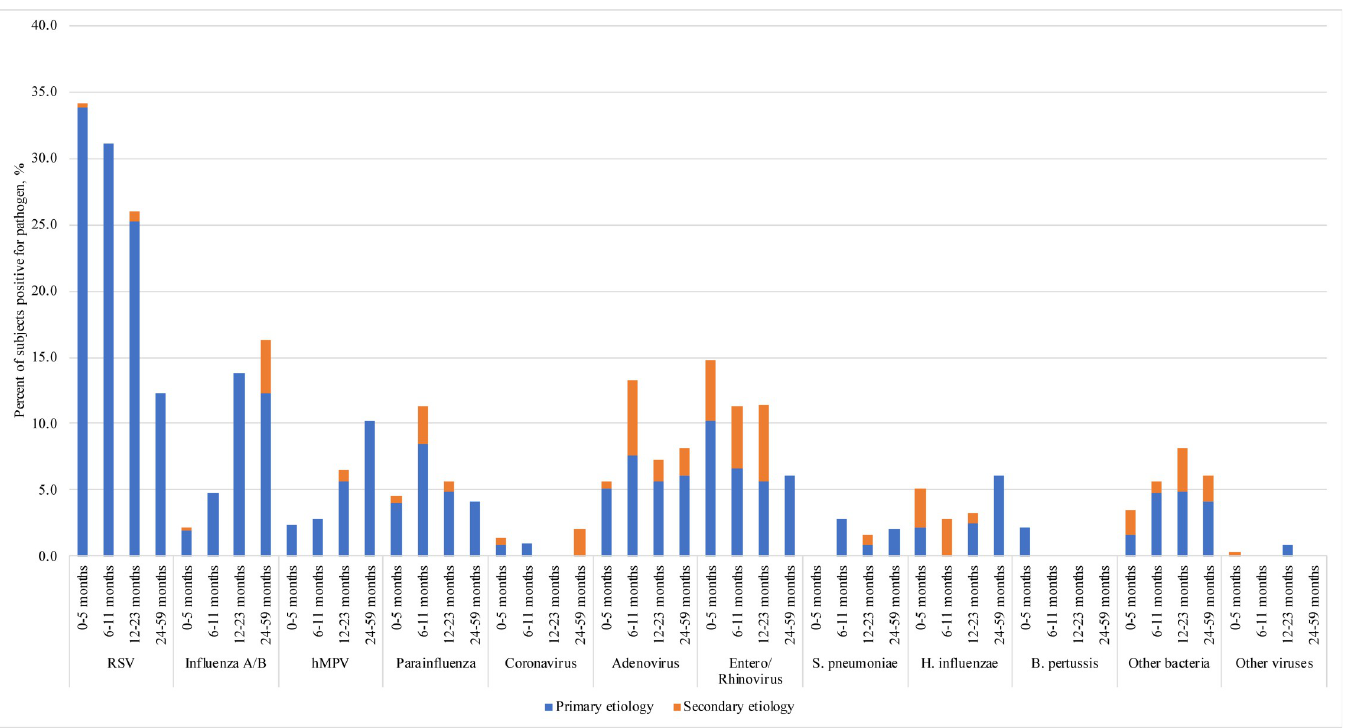
Fig 2. Identified pathogens by age group, and primary or secondary infectious etiology. Other bacteria: For primary etiology: M . catarrhalis n = 1/1/0/0; Acetinobacter spp n = 0/1/1/0; C . trachomatis n = 1/0/0/0; S . viridans n = 1/0/1/0; MRSA n = 1/0/1/1; MSSA n = 0/0/1/0; Group A strep n = 1/3/1/1; Group B strep n = 1/0/1/0; For secondary etiology: M . catarrhalis n = 6/0/3/1; MRSA n = 1/0/1/0; TB n = 0/1/0/0. Other viruses: For primary etiology: Cytomegalovirus n = 0/0/1/0; For secondary etiology: bocavirus n =